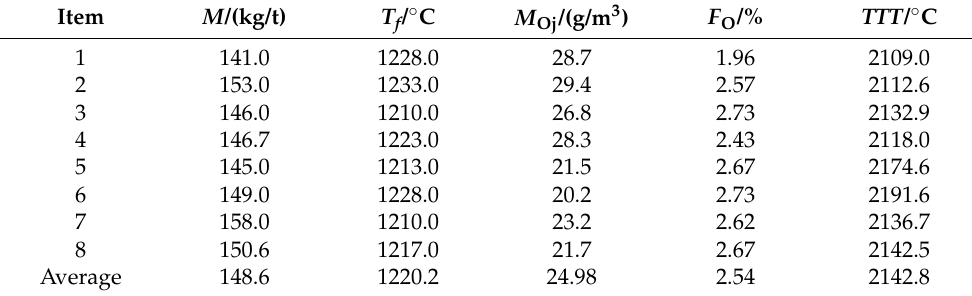
Table 1. Operation data of the 4350 m 3 BF in